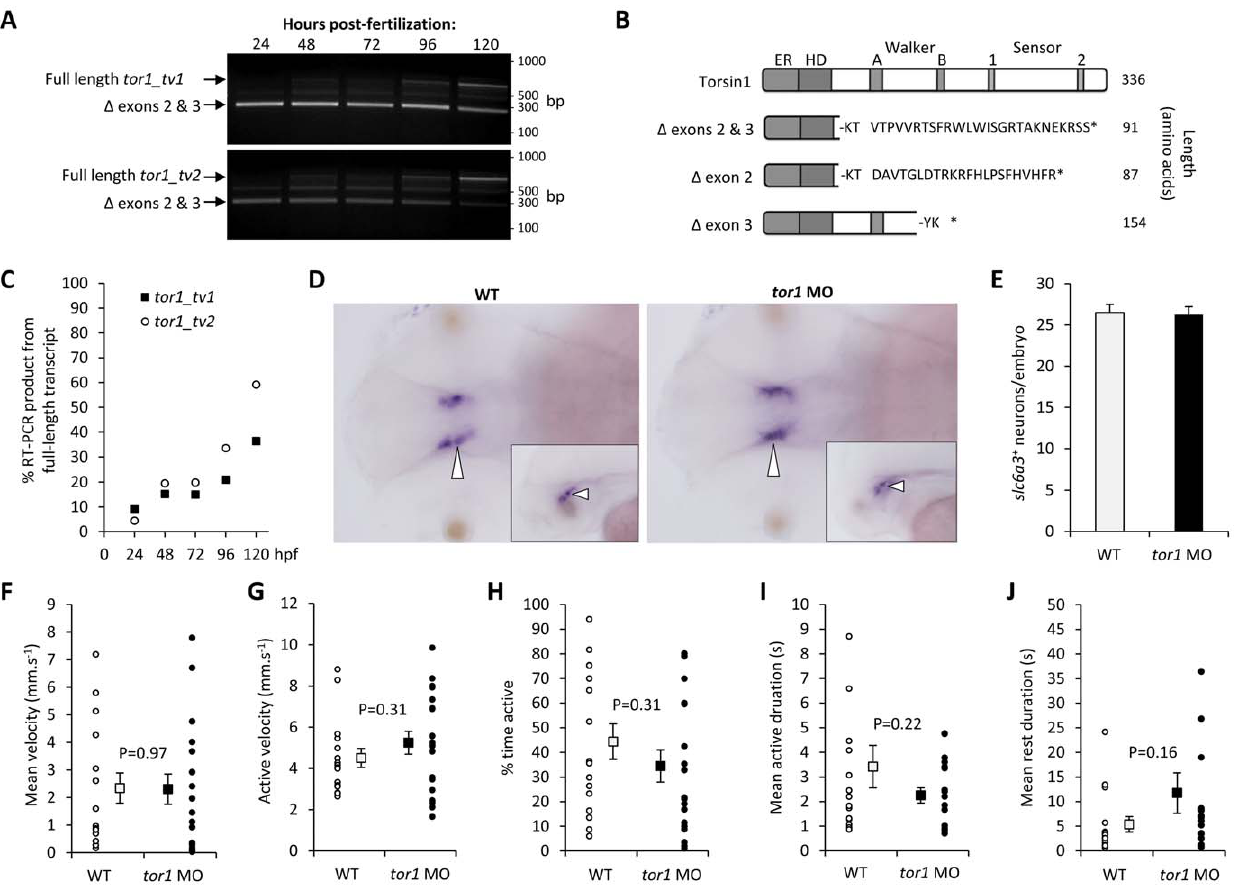
Figure 10. Torsin1 is non-essential for early development of the motor system. A: Single-cell zebrafish embryos were microinjected with morpholino oligonucleotides designed to block splicing of tor1 exons 2 and 3 (see figure 2). At the times indicated between 24 and 120 hours post- fertilization, RNA was harvested from developing zebrafish and subjected to RT-PCR using primers specific for tor1_tv1 (upper panel) or tor1_tv2 (lower panel). The pictures show ethidium bromide stained agarose gels after the PCR products were resolved by electrophoresis. The positions of PCR products corresponding to wild-type tor1 mRNA and the transcript lacking exons 2 and 3 are shown. B: A schematic representation is shown of the predicted protein products produced by transcripts lacking exons 2, 3 or both exons. It is not known if any of these truncated products is stable. C: The % tor1 RT-PCR product arising from the wild-type, full-length mRNA at each time point following MO injection was estimated by densitometry. D: Whole mount RNA in situ hybridization was carried out using a cRNA probe for slc6a3 (‘ dat ’) to localize dopaminergic neurons. Representative dorsal views are shown of the brains of an uninjected control embryo (left panel) and an embryo lacking Torsin1 (right panel) at 48 hours post- fertilization. The inset panels show representative lateral views. Developing dopaminergic neurons in the diencephalon are indicated by arrowheads. E: The total number of slc6a3 + cells in the diencephalon was counted in zebrafish lacking Torsin1 and control zebrafish at 48 hpf. Graphs show mean number of cells, error bars show standard error. F–J: Spontaneous movements of uninjected wild-type zebrafish (n=16) and zebrafish injected with MO targeting tor1 (n=19) were recorded at 5 dpf in 96-well plates using a video camera. Recordings were analyzed to determine: (F) mean velocity (total displacement/total time of recording); (G) active velocity (displacement/time spent moving); (H) % time active; (I) mean duration of active episodes; and (J) mean duration of rest episodes. For each graph, values for each individual larva are shown as small circles and the mean for the group shown as a filled square. Error bars shown standard